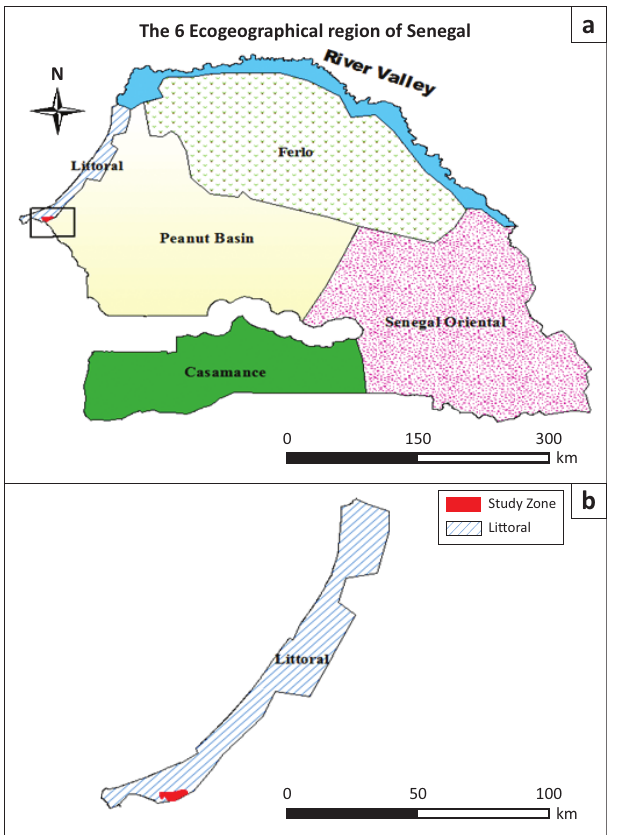
FIGURE 1: Location of the study area. (a) The Niayes region within Senegal and (b) within the littoral.